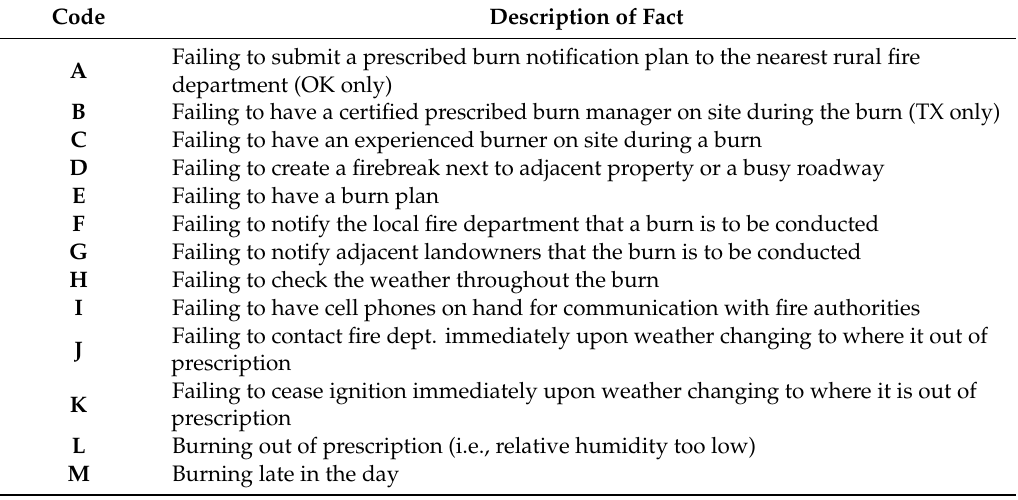
Table 1. List of facts that Texas and Oklahoma judges could select from as facts they deemed to constitute evidence of simple or gross negligence in an escaped prescribed fire